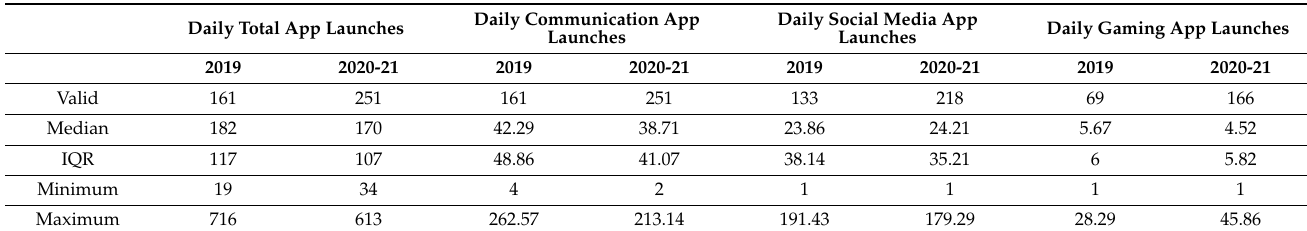
Table 2. A summary of the daily average number of app launches in 2019 and 2020-21.